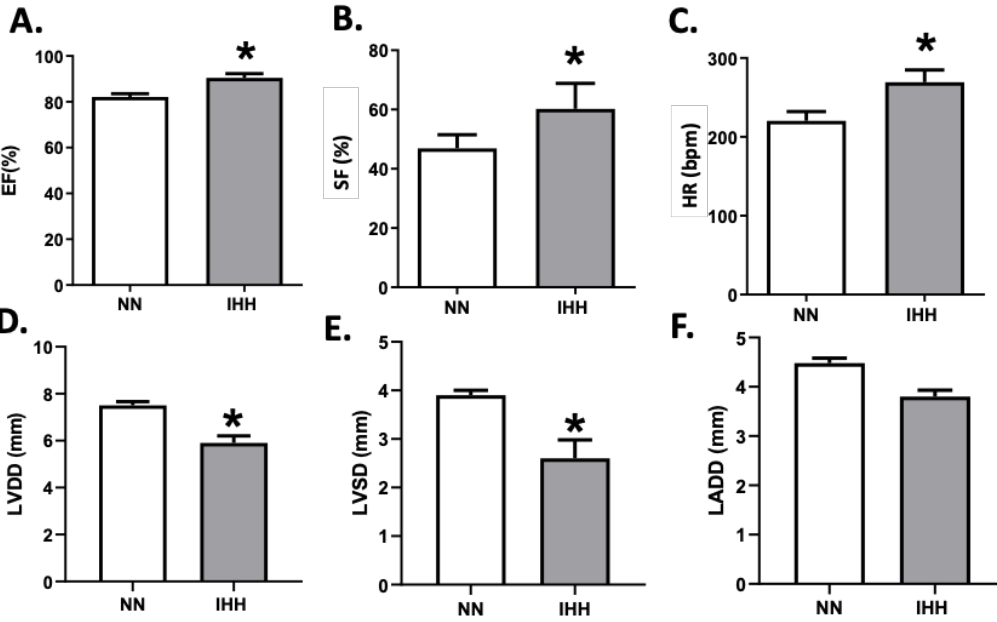
Figure 2. Echocardiographic parameters . The left cardiac function was evaluated by ultrasound echocardiography through the ejection fraction (EF%, ( A )), shortening fraction (SF%, ( B )), heart rate (HR, ( C )), left ventricular diastolic diameters (LVDD, ( D )), the systolic diameter of the left ventricle (LVSD, ( E )) and left atrial diameter (LADD, ( F ). Groups are normobaric normoxia (NN, n = 6) and intermittent hypobaric hypoxia (IHH, n = 6). Data are expressed in mean ± SEM. Significant differences ( p ≤ 0.05): * vs. NN.